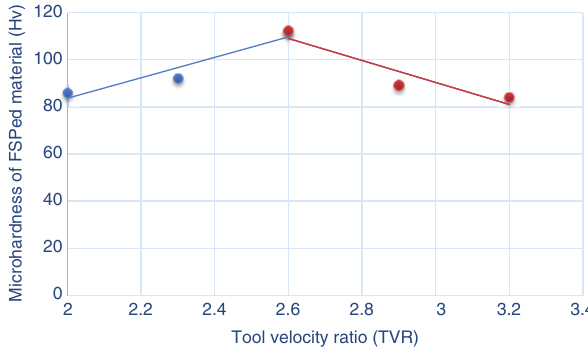
Figure 10: Effect of TVR on hardness of the FSPed